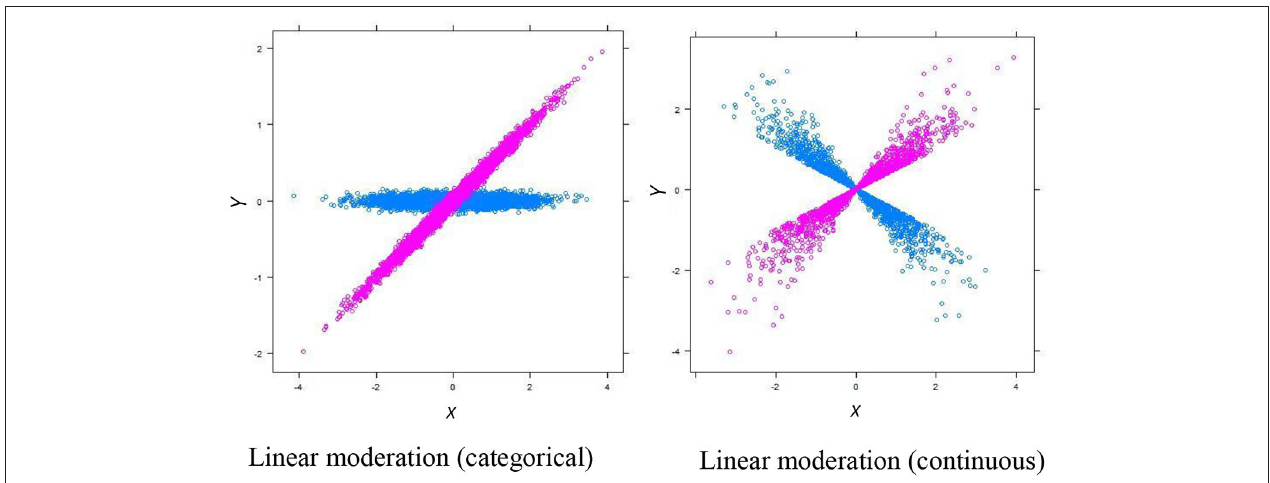
FIGURE 1 | Diagrams that show linear moderations (with a categorical moderator M on the left and a continuous moderator M on the right). The blue dots are the selected cases with a lower value in M [i.e., M = 0 for the categorical moderation, and M = − 1 (1 SD below mean) for the continuous moderation]. The purple does are the selected cases with a higher value in M [i.e., M = 1 for the categorical moderation, and M = 1 (1 SD above mean) for the continuous